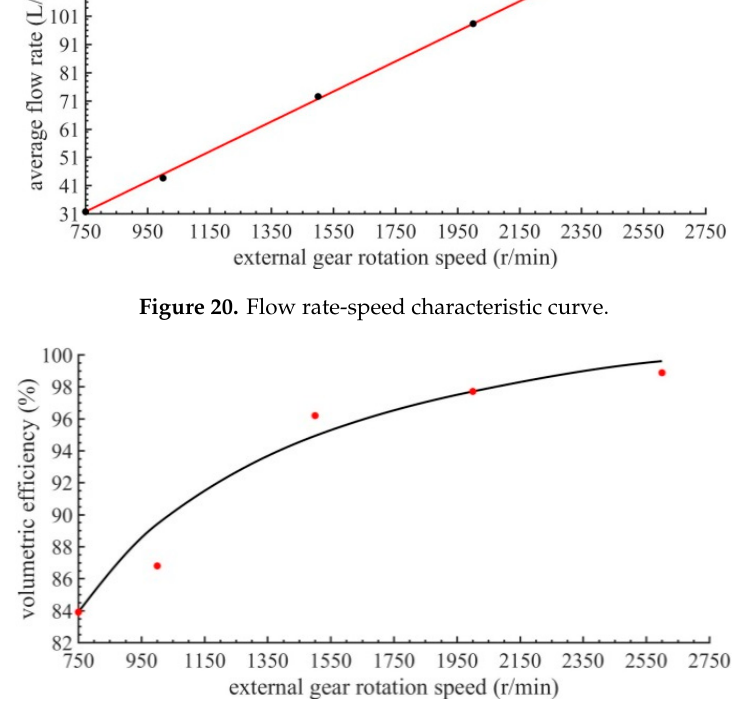
Figure 21. Volumetric efficiency–speed characteristic curve.